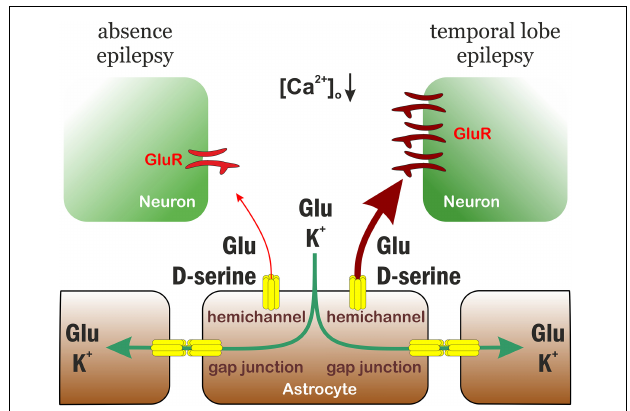
FIGURE 4 | Proposed model for differential role of astrocytic gap junctions in seizure spreading in temporal lobe and absence epilepsies. The astrocytic connexin Cx43 has a dual role in temporal lobe and absence epilepsies. It performs an anti-epileptic action by spatial distribution of Glu and K + . On the other hand, connexin hemichannels release Glu and D -serine that increases neuronal excitation, therefore contributes to seizure generation and maintenance. The weight of the two pathways, however, are distinct in temporal lobe and absence epilepsies, because the expression level of neuronal (extrasynaptic) Glu receptors is significantly higher in temporal lobe epilepsy. Consequently, the final outcome of connexin activation is an anti-epileptic effect in absence epilepsy, but a pro-epileptic effect in temporal lobe epilepsy.